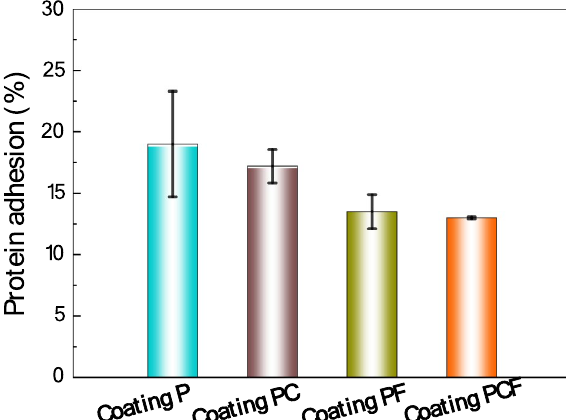
Figure 6. The BSA protein adhesion on the 4 different coatings.